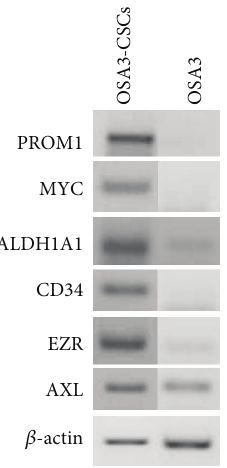
Figure 26: Expression of the cancer stem cells marker genes. RT- PCR show the expression of PROM1, MYC, ALDH1A1, CD34, EZR, and AXL in OSA3-CSCs and in